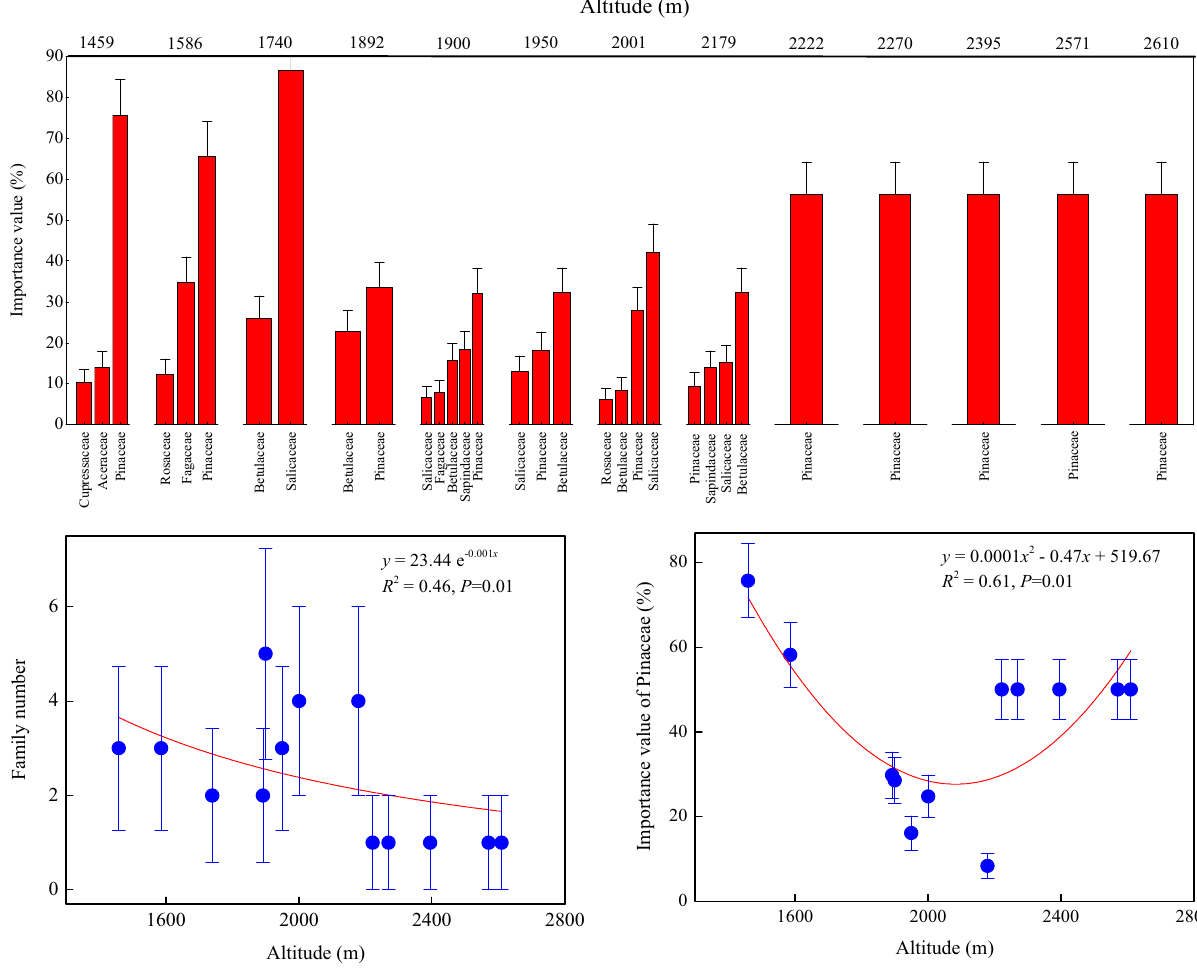
Figure 5. Distribution and variation of the importance values and numbers of tree families at different elevations. Thirteen elevations were observed for the tree community. At each elevation, the importance values of the tree families were arranged in ascending order to obtain the dominant family. Data for each tree family were averaged from 20 sub-quadrats at each elevation. Regression analyses were performed on the relationships between the family number of the tree community and the importance value of the dominant family (Pinaceae) along the altitudinal